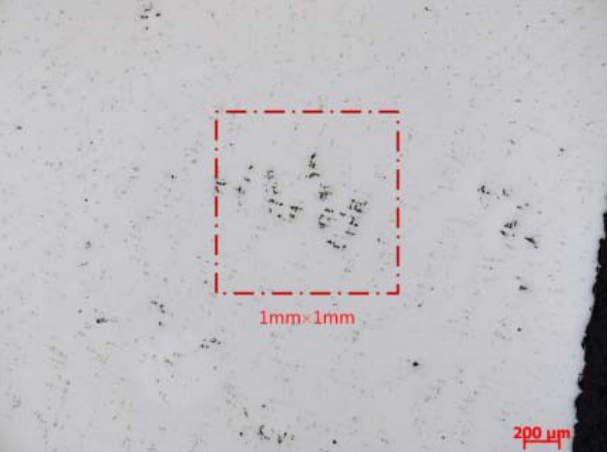
Figure 13. Optical view of microporosity, and the content of microporosity, 1.26%.